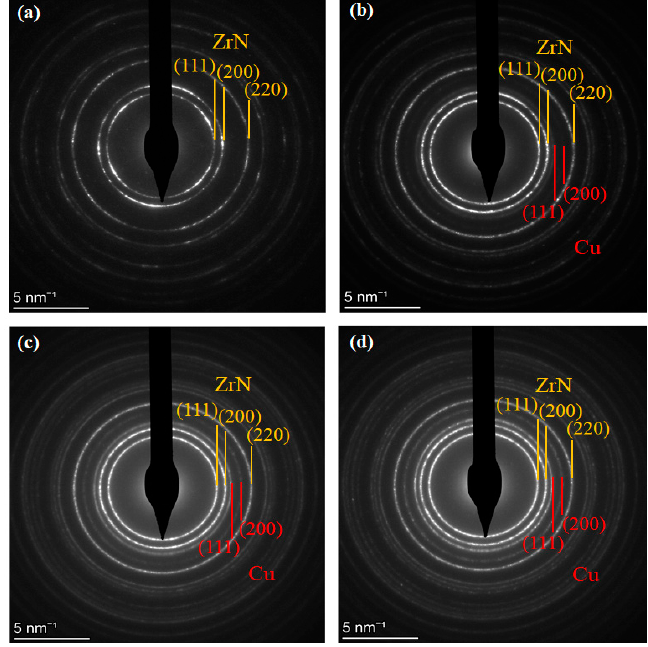
Figure 6. SAED patterns of ( a ) Cu6; ( b ) Cu12; ( c ) Cu25; and ( d )